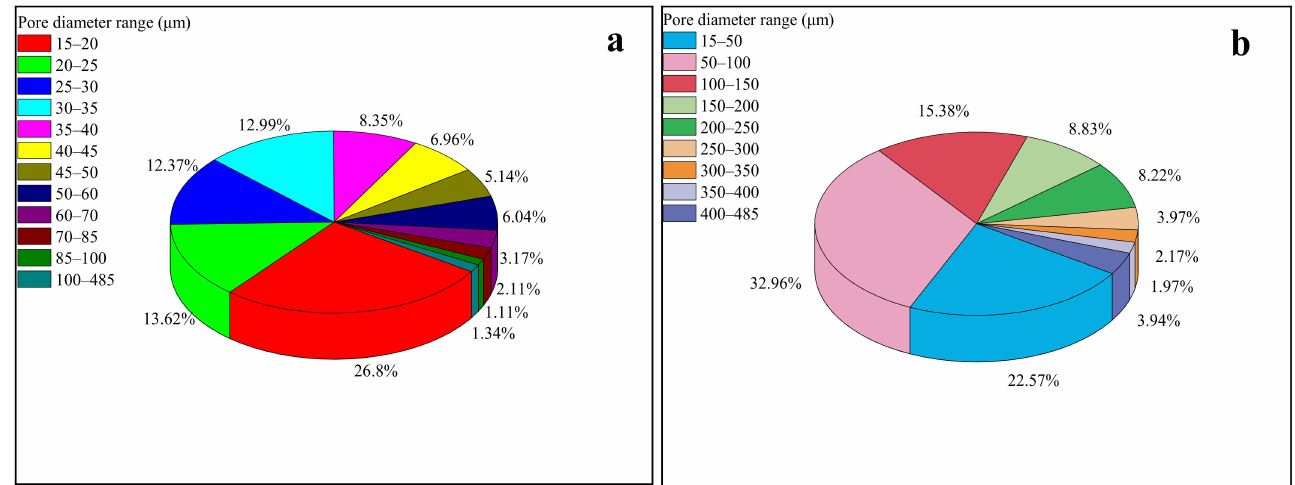
Figure 6. The percentages of ( a ) pore quantities and ( b ) pore volumes in different diameter ranges of W2L1-28d.